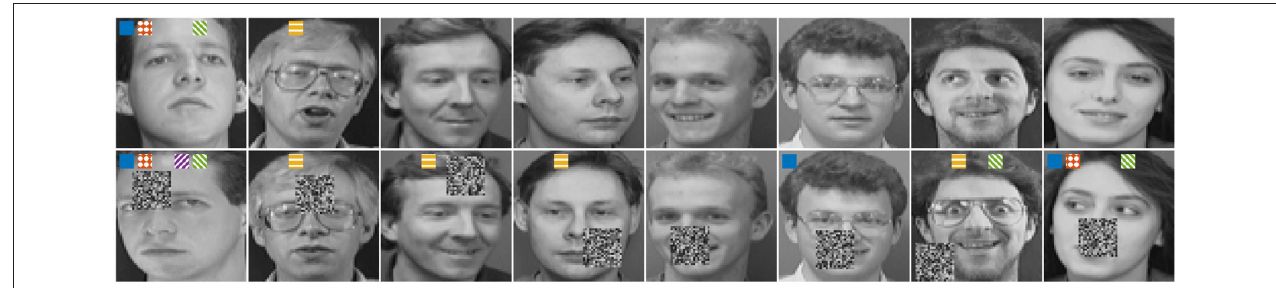
FIGURE 3 | Example images from the face database. Eight original images at the top, and eight images with added artifacts at the bottom. Marked images correspond to top 10% outlier score for OCSVM (Blue), distance to center of mass (Orange), IsoMap (Yellow), Percolation (Purple), and Ramaswamy (Green).